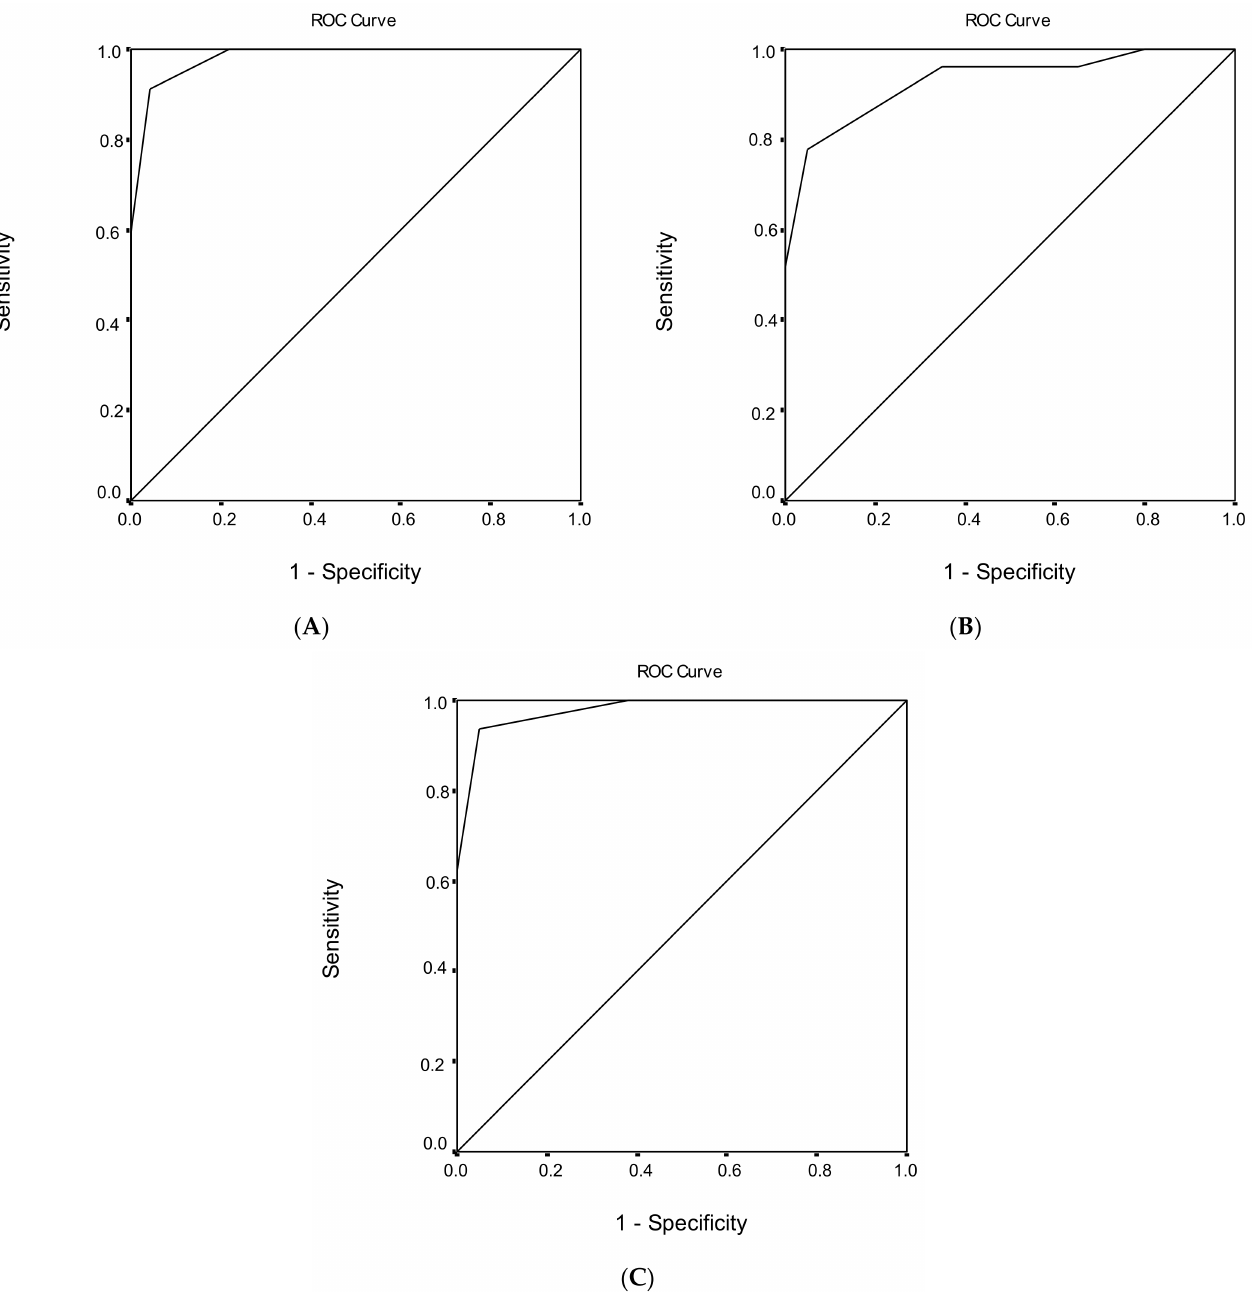
Figure 2. Receiver operating characteristic (ROC) curve analysis of the Montreal Cognitive Assessment (MoCA) to discriminate between healthy subjects and mild cognitive impairment (MCI) under ( A ) low, ( B ) medium, and ( C ) high educational